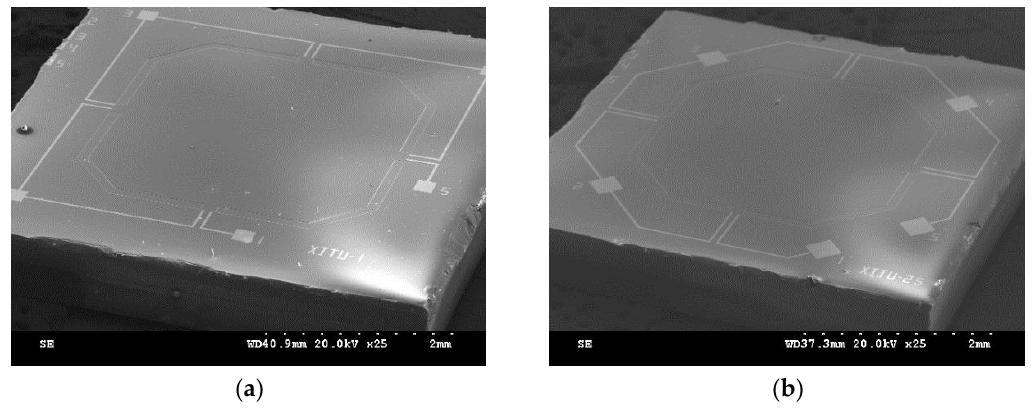
Figure A3. SEM pictures of fabricated sensing chips with different bossed diaphragms: ( a ) improved diaphragm I; ( b ) improved diaphragm II.